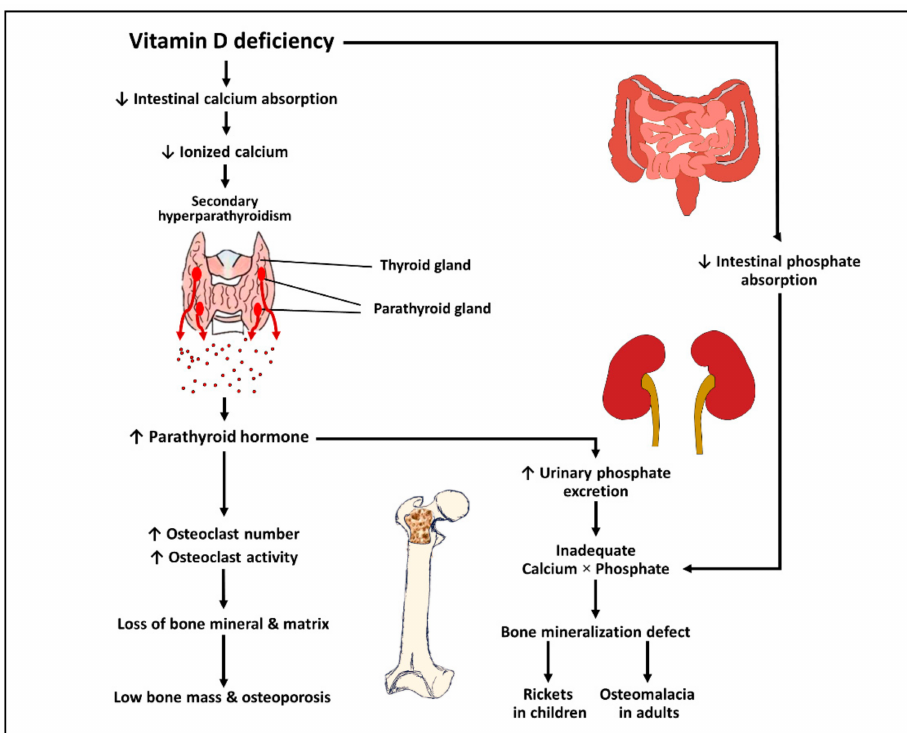
Figure 2. Schematic representation of the pathophysiology of vitamin D deficiency causing rickets, osteomalacia, and osteoporosis. ↑ : Increased; ↓ :